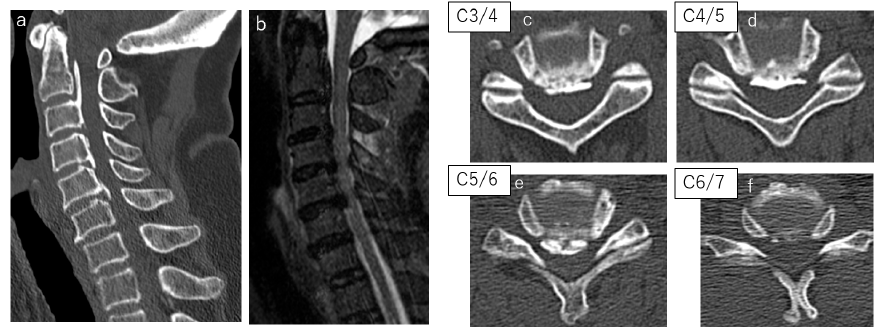
Figure 3. ( a ) preoperative CT sagittal image; ( b ) preoperative MRI image (T2); ( c ) preoperative CT axial image (C3/4); ( d ) preoperative CT axial image (C4/5); ( e ) preoperative CT axial image (C5/6); ( f ) preoperative CT axial image (C6/7).